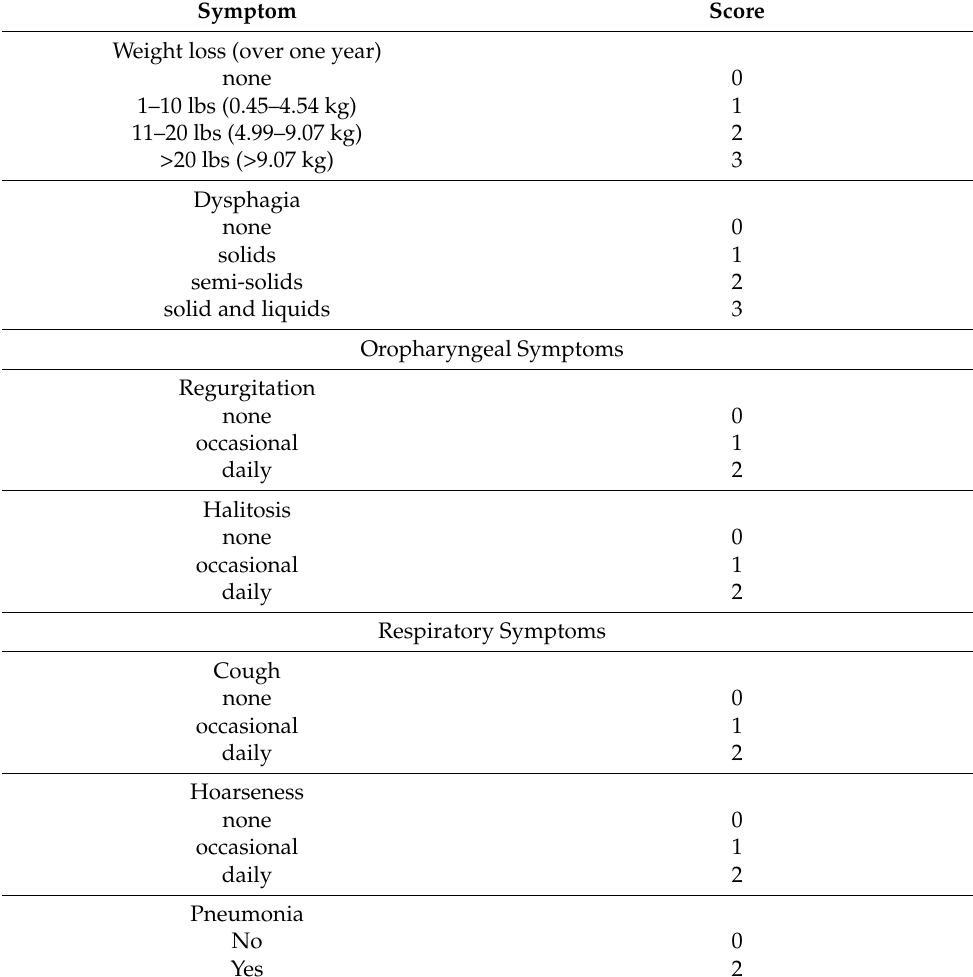
Table 1. Kothari-Haber Scoring System for Zenker’s Diverticulum